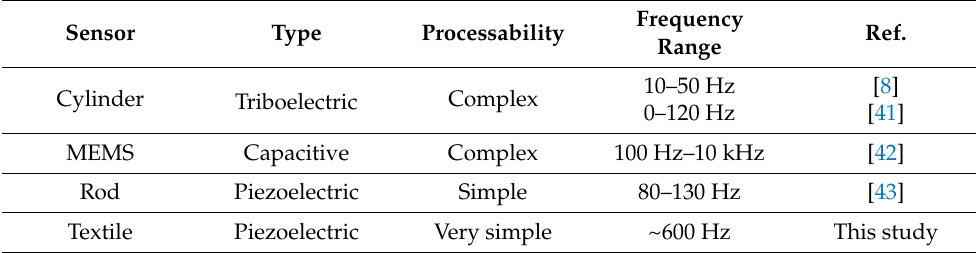
Table 1. Comparison of vibration − frequency